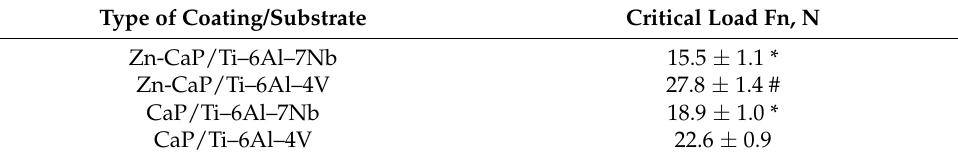
Table 4. Scratch test results of deposited CaP coatings on Ti-based substrates, X ± S.E.M. Type of